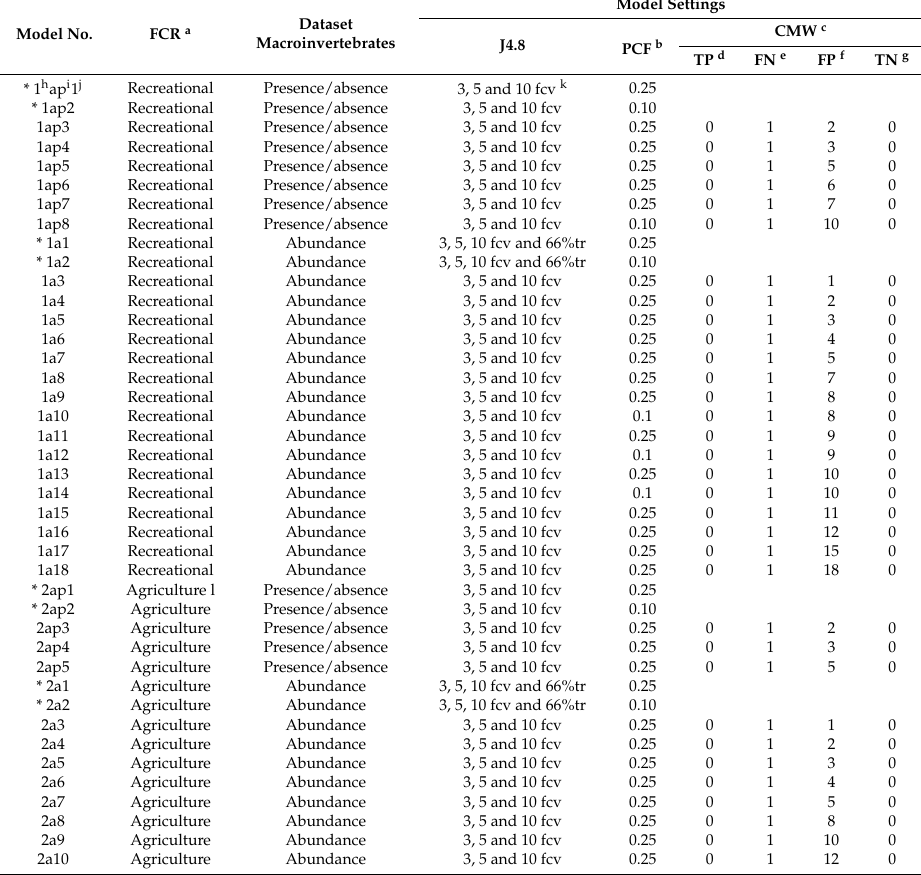
Descriptive statistics of physicochemical and microbiological variables are given as mean values ± standard deviations, minimums and maximums. NTU = Nephelometric turbidity units. HU = Hazen units. MPN = Most probable number. BDL = Below Detection Limit. Table A2. Models settings used in Weka before and after optimization analysis, in which was included Cost Matrix Weights